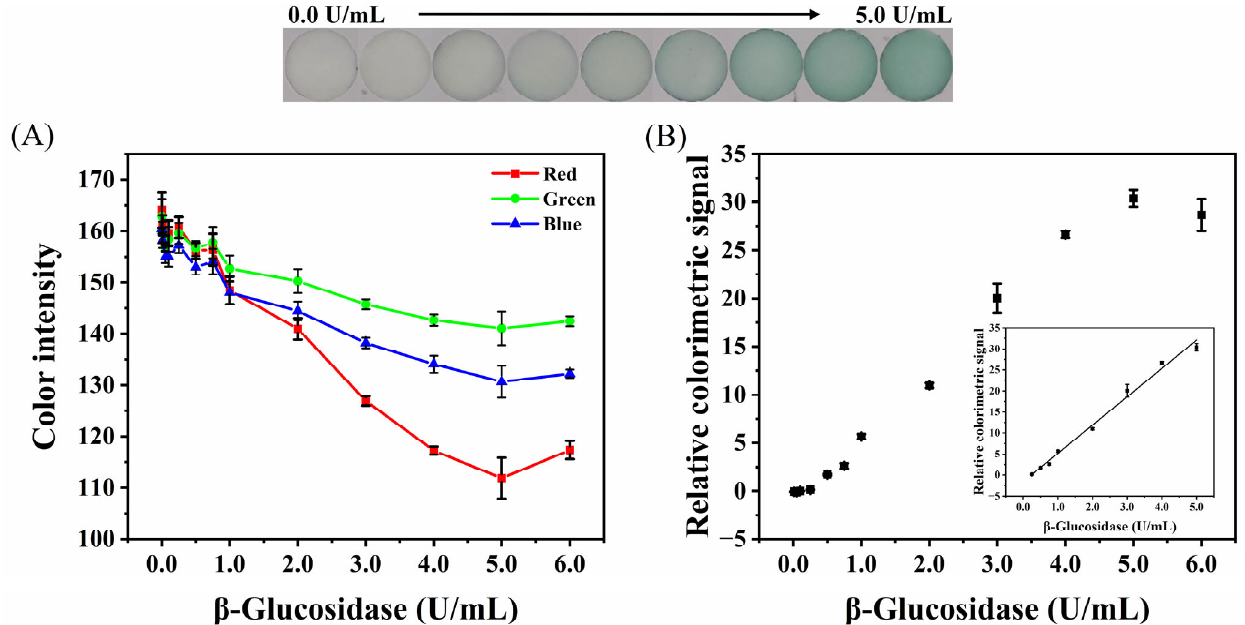
Figure 7. ( A ) Intensity of RGB channels in colorimetric images of the paper-based devices with different activity of β -glucosidase. ( B ) The relative colorimetric value of the paper-based device is changed with the activity of β -glucosidase. Inset: calibration plot in the linear range of 0.25–5.00 U/mL. Photographs: colorimetric images of paper-based device at different β -glucosidase activity.